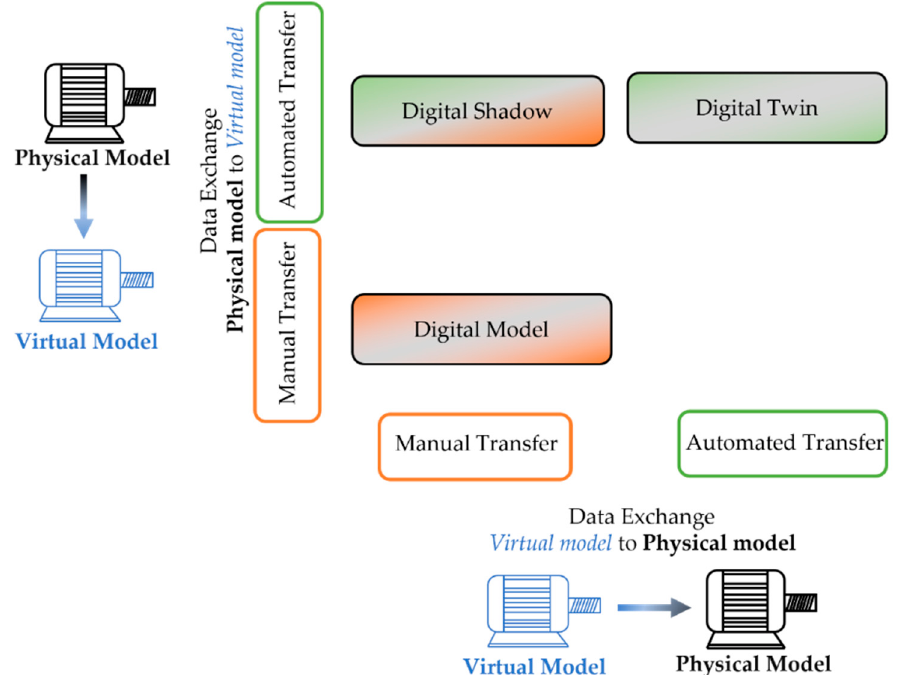
Figure 4. Representation of transfer of data between the physical model and the virtual model.